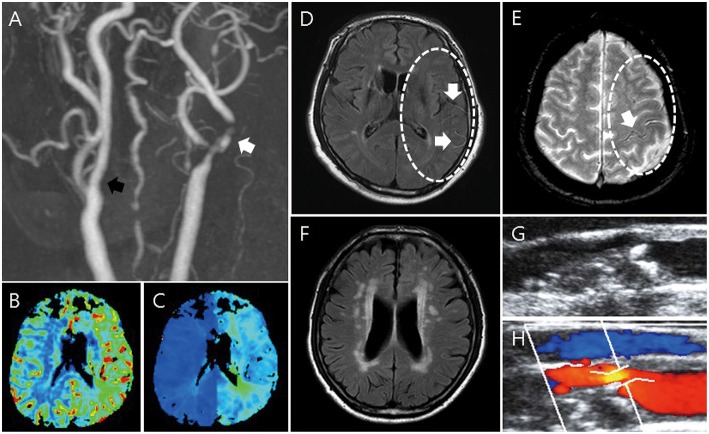
Imaging parameters: MRI, CTA/MRA, PWI, and carotid duplex sonography. MRA shows stenosis of the proximal internal carotid artery (A, white arrow) and contralateral carotid artery stenosis (A, black arrow). In PWI, increased CBV (B) and delayed TTP (C) are shown. FLAIR shows HVS in FLAIR (D) and PWMH/DWMH (F). GRE shows HV in GRE (E). Through duplex carotid sonography, plaque characteristics such as calcification, ulceration, echolucent, and stenosis are shown (G,H).